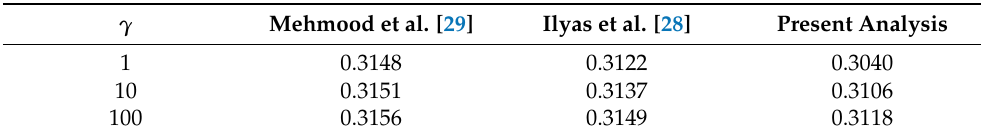
Table 1. The numerical results of skinfriction for various choices of magnetic Prandtl parameter 𝛾 =